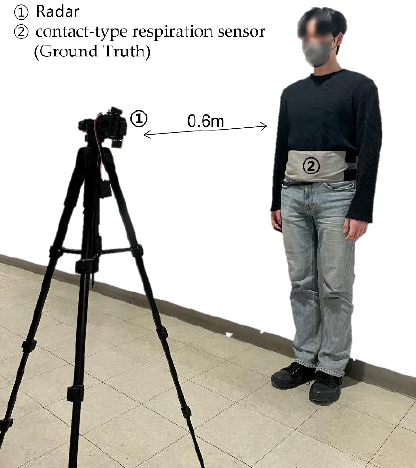
Figure 6. Location of subject and radar test equipment.